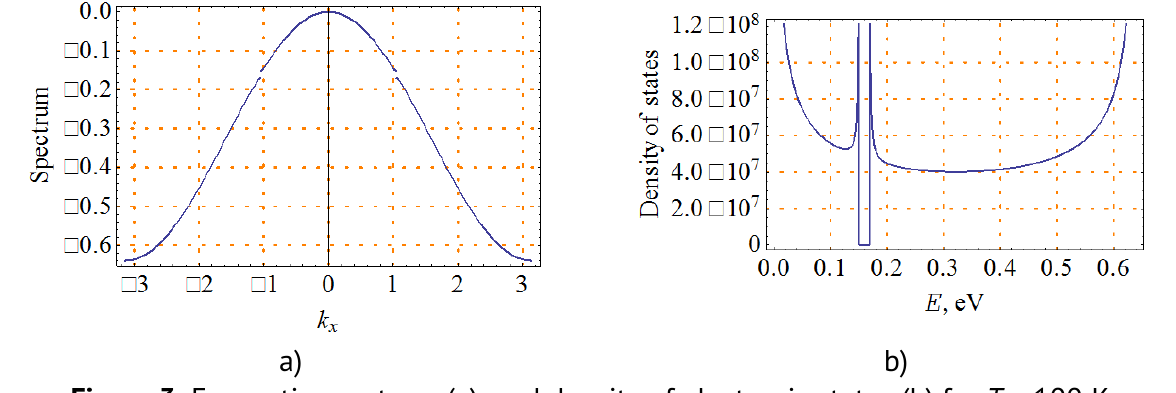
Figure 3. Energetic spectrum (a), and density of electronic states (b) for T = 100 K.